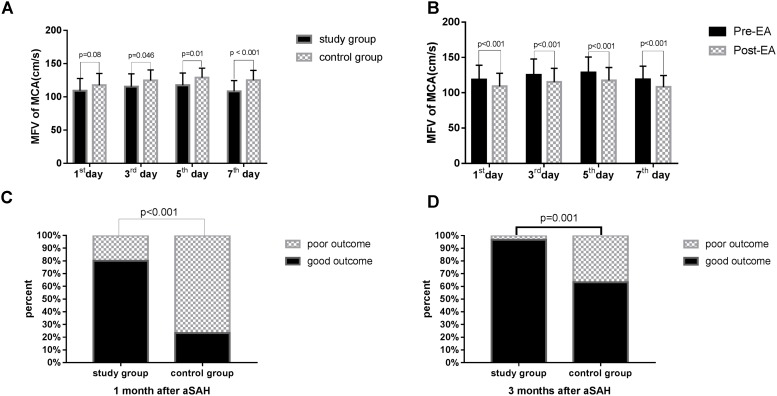
The MFV in MCA and the outcome in the two groups. MFV, mean flow velocity; MCA, middle cerebral artery. The GOS score was used 1 or 3 months after surgery to assess the clinical outcome of patient survival. (A) Comparison of MFV in MCA in the study group versus control group on the 1st, 3rd, 5th, and 7th day after surgery. The data were analyzed using student’s t-test. (B) Comparison of MFV in MCA in the study group pre-EA versus post-EA on the 1st, 3rd, 5th, and 7th day after surgery. The data were analyzed using student’s t-test. (C) Comparison of outcome in the study group versus control group 1 month after surgery The data were analyzed using chi-square test. (D) Comparison of outcome in the study group versus control group 3 months after surgery. The data were analyzed using chi-square test.